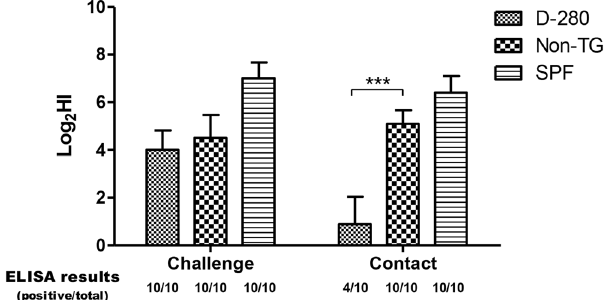
Figure 8. Serum antibody levels and c-ELISA results of challenged and contact exposed chickens. Serum samples were collected three weeks after challenge. Seroconversion was detected using competitive ELISA targeting nucleoprotein antibodies. Mean hemagglutination inhibition (HI) titer were compared between transgenic and non-transgenic chickens. Each error bar represents standard deviation. *** p < 0.001 by unpaired t